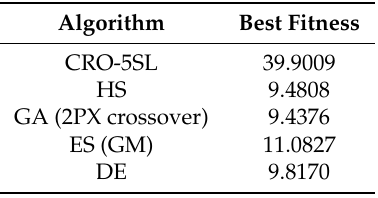
Table 4. Comparative results of the CRO-5SL and alternative metaheuristic performance (in terms of the objective function given by Equation (1)).